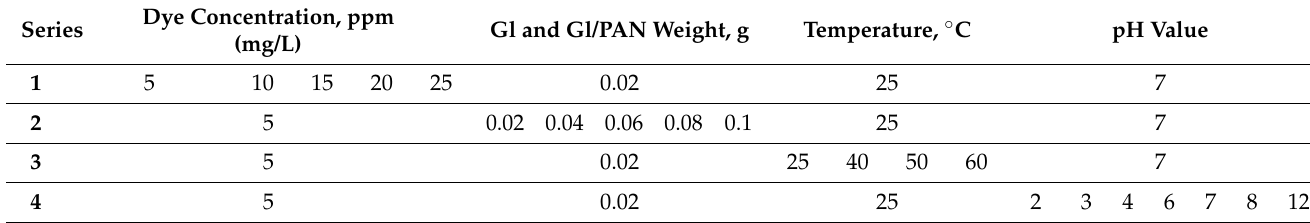
Table 1. Conditions of experimental